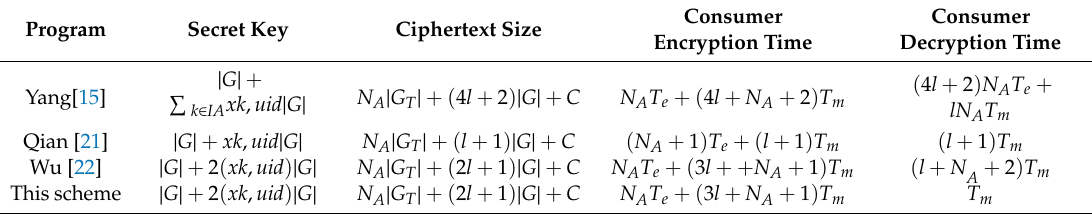
Table 2. Calculation cost comparison.